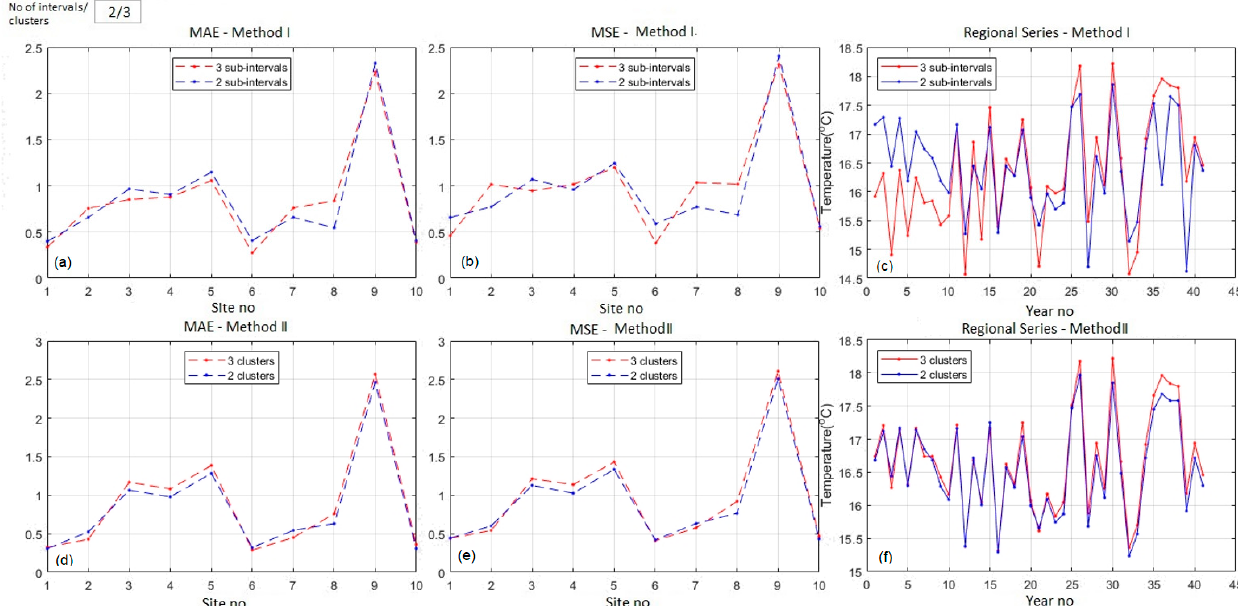
Figure 12. The case of two and three intervals/clusters for the series of maximum temperatures: ( a ) the regional series; ( b ) MAE and MSE — Method I; ( c ) MAE and MSE — Method II; ( d ) comparisons of MAEs; ( e ) comparisons of MSEs; ( f ) min, max, and amplitude of the average temperatures series. Table 4. Comparative results of Methods I and II for the maximum temperatures series for two and three intervals/clusters (°C) .